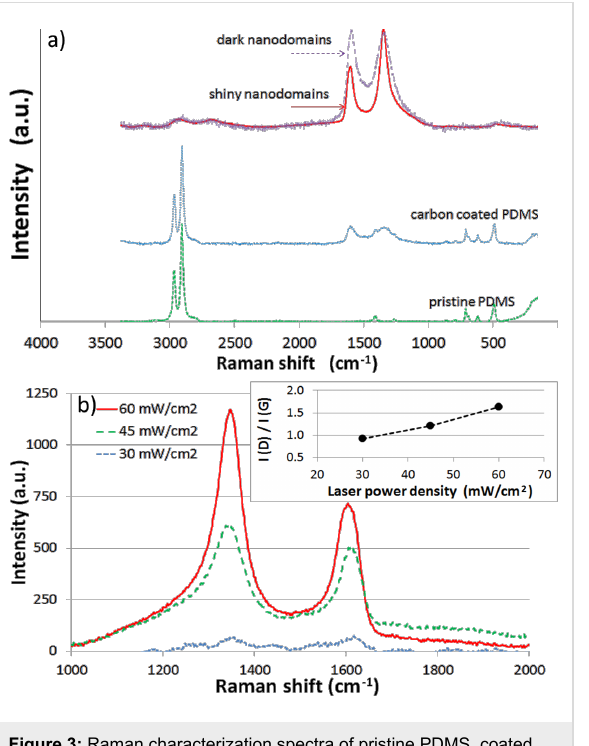
Figure 3: Raman characterization spectra of pristine PDMS, coated PDMS and residual nanodomains of shiny and dark domains in etched channels after cleaning (a). Influence of laser power density on G and D bands intensities